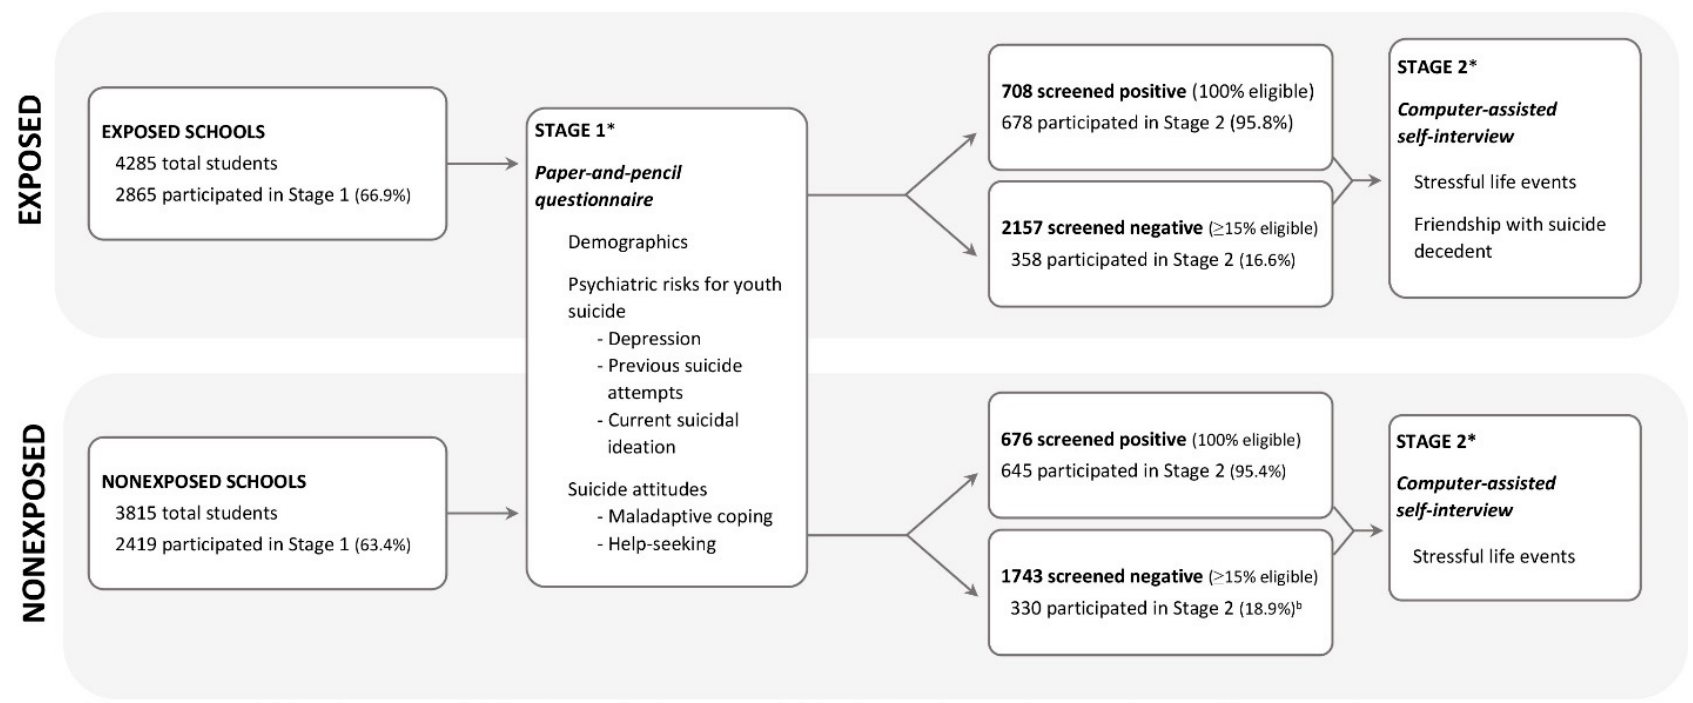
Figure 1. Two ‐ Stage Study Procedure and the Flow of Participants. Figure 1. Two-Stage Study Procedure and the Flow of